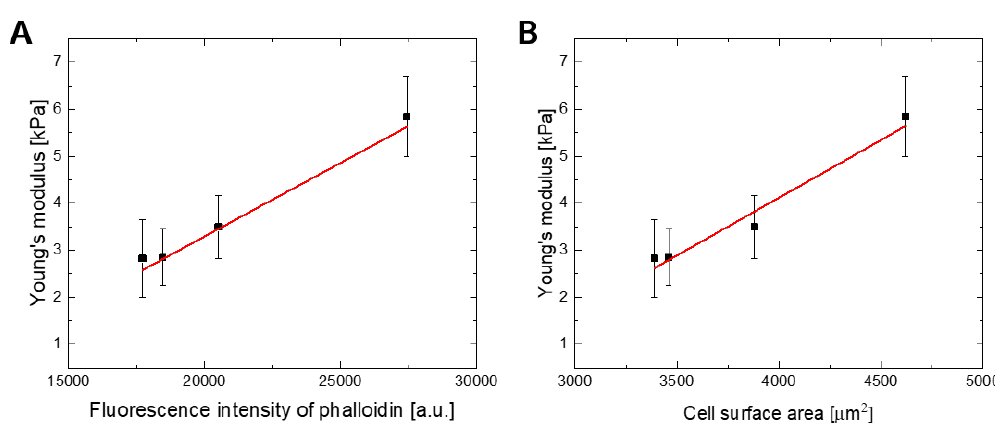
Figure 6. A linear relation on ( A ): Young’s modulus values of WJ-MSCs for an indentation depth of 300 nm and the fluorescence intensity of phalloidin (a goodness of the linear fit was quantified by the Pearson’s coe ffi cient; Pearson’s r = 0.978), ( B ) Young’s modulus values of WJ-MSCs for an indentation depth of 300 nm and cell surface area (Pearson’s r = 0.981).